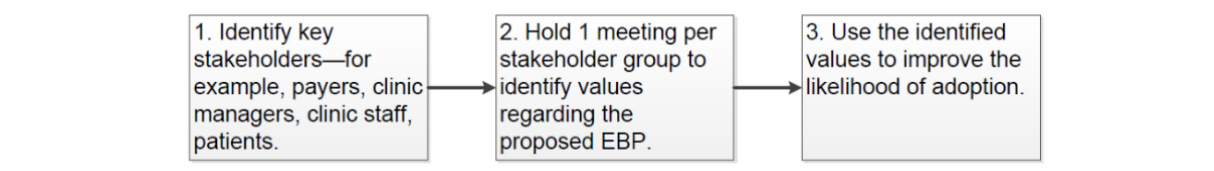
Figure 2. Decision-framing model. EBP: evidence-based